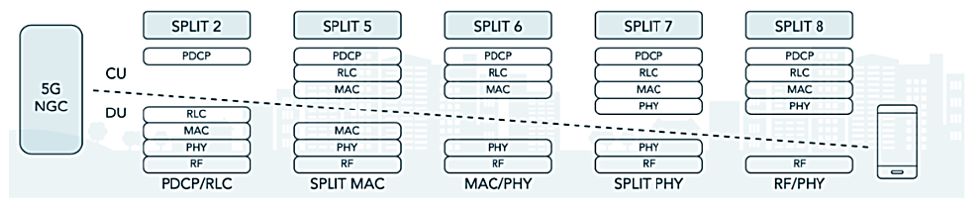
Figure 7. RAN splits—logical to sub-Layer 5G NR/NGC SA. Based on